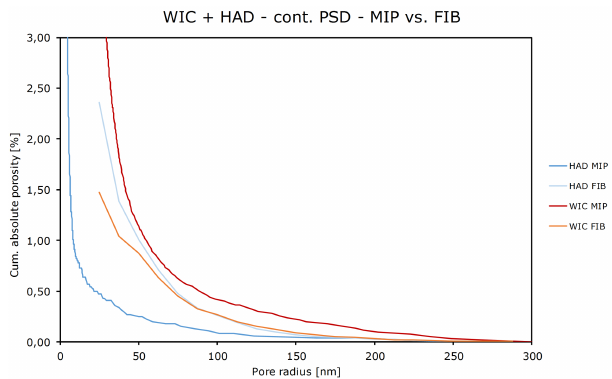
Figure 5. Plot of continuous pore size distribution (FIB), com- pared to mercury intrusion porosimetry (MIP) data from Kaufhold et al.